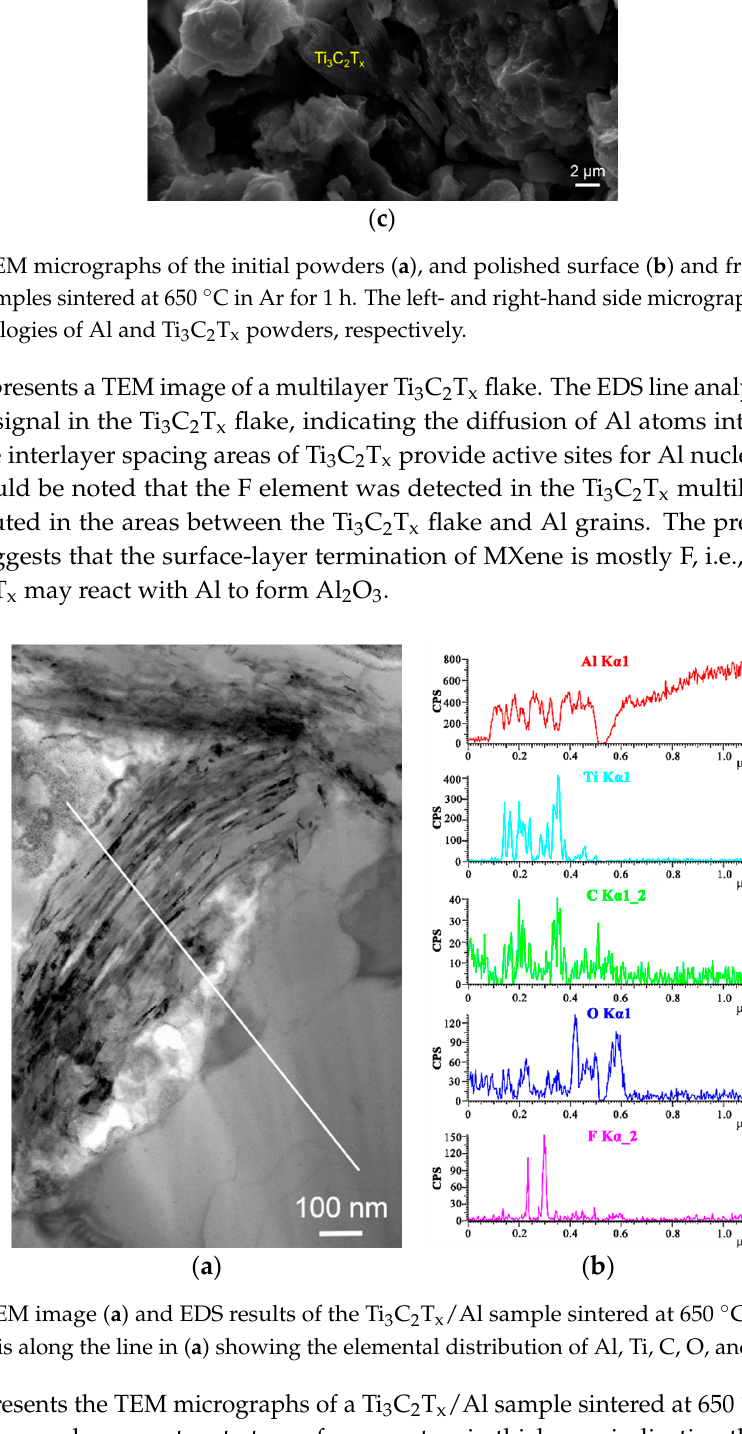
Figure 3. SEM micrographs of the initial powders ( a ), and polished surface ( b ) and fracture surface ( c ) of the samples sintered at 650 °C in Ar for 1 h. The left- and right-hand side micrographs in ( a ) show the morphologies of Al and Ti 3 C 2 T x powders, respectively.